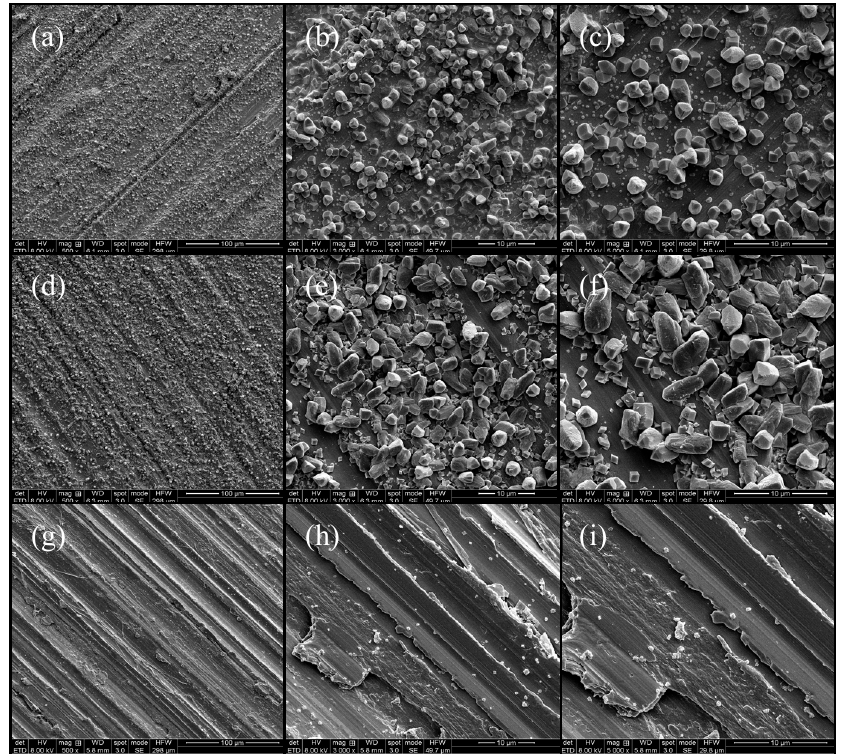
Figure 8. SEM diagrams of passive film at different temperatures: ( a – c ) are passive film at 20 °C, ( d – f ) are passive film at 40 °C, and ( g – i ) are passive film at 60 °C.